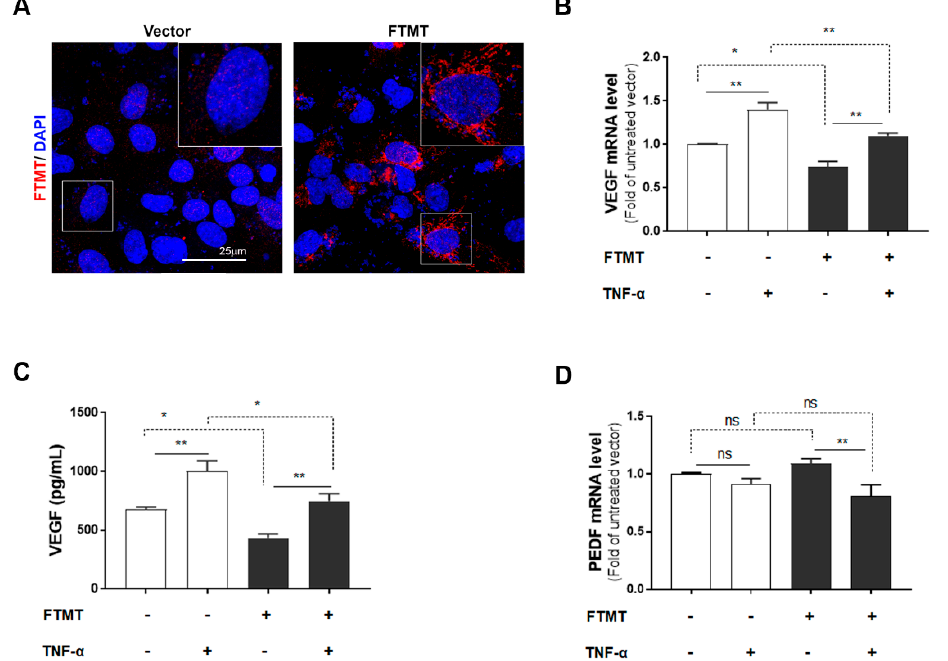
Figure 5. Effects of FTMT overexpression on VEGF secretion in ARPE-19 cells: ( A ) Overexpression of FTMT in ARPE-19 cells. Cells were transfected with pEGFP-N1 vector or FTMT expressing constructs for 48 h. Transfection efficacy was assessed by immunocytochemistry. Scale bar represents 25 μ m. FTMT overexpressing ARPE-19 cells were incubated with or without TNF- α (10 ng / mL), and ( B ) the relative mRNA levels of VEGF were analyzed by qPCR and normalized by the ACTB gene. ( C ) VEGF protein expression in the supernatants measured by ELISA. ( D ) The relative mRNA levels of PEDF were analyzed by qPCR and normalized by the ACTB gene using the same samples as in Figure 5B. Data were analyzed by one-way ANOVA with Sidak’s test (* p < 0.05; ** p < 0.01, n = 4). Results are shown as the mean ±